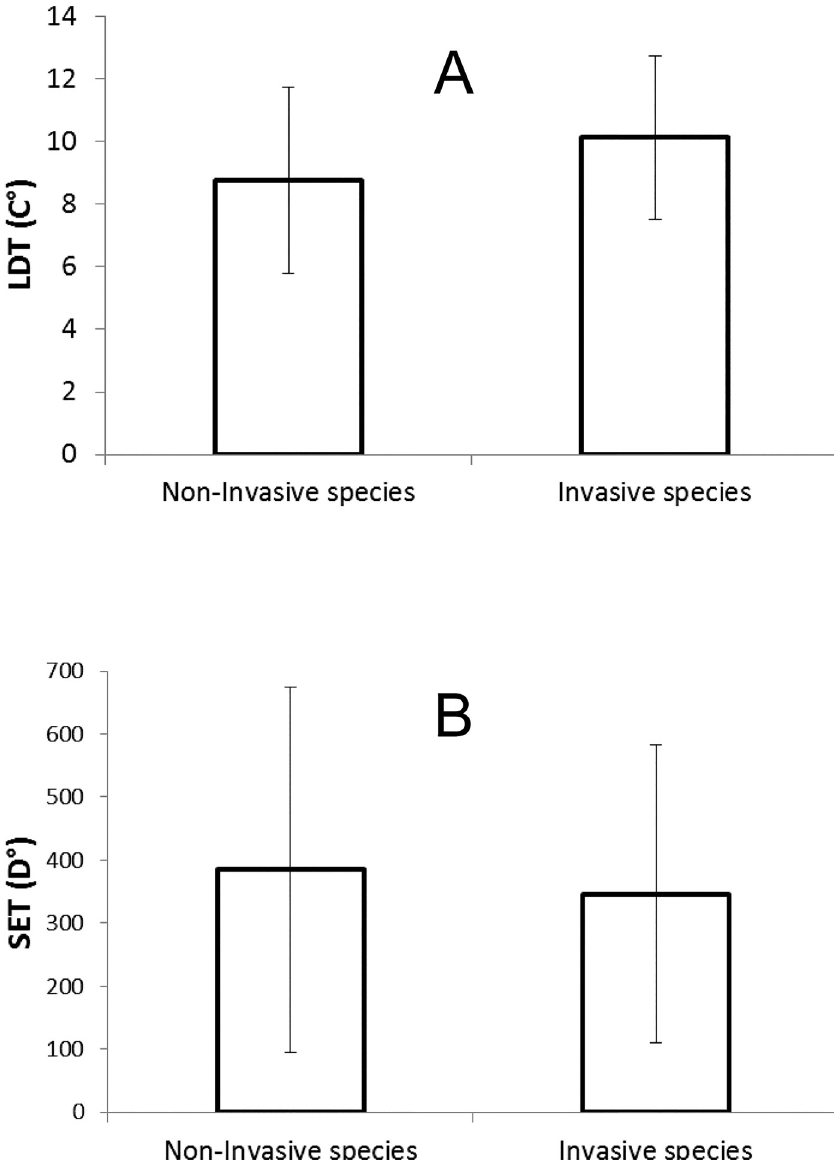
Fig 1. Lower developmental thresholds (LDTs) and sums of effective temperatures (SETs) of non- invasive and invasive species. Average values ± standard deviations of LDTs in °C, (A) and SETs in day degrees [D°] above LDT (B) for pairs of related species of which one is invasive and the other is not. (A) Invasive species have significantly higher LDTs than non-invasive species: t = 4.38, df = 99, P < 0.001 (two- sample t-test not taking into account that paired differences can vary specifically depending on species relatedness); t = 3.841, df = 93, P < 0.001 (linear mixed-effect model on closely related species pairs, analogous to paired t-test); t = 4.35, df = 177.9, P < 0.001 (linear mixed-effect model on nested taxonomic hierarchy). (B) Invasive species have non-significantly lower LDTs than non-invasive species: t = 1.52, df = 87, P = 0.13 (two-sample t-test not taking into account that paired differences can vary specifically depending on species relatedness); t = 1.23, df = 81, P = 0.22 (linear mixed-effect model on closely related species pairs, analogous to paired t-test); t = 1.29, df = 154.9, P = 0.2 (linear mixed-effect model on nested taxonomic